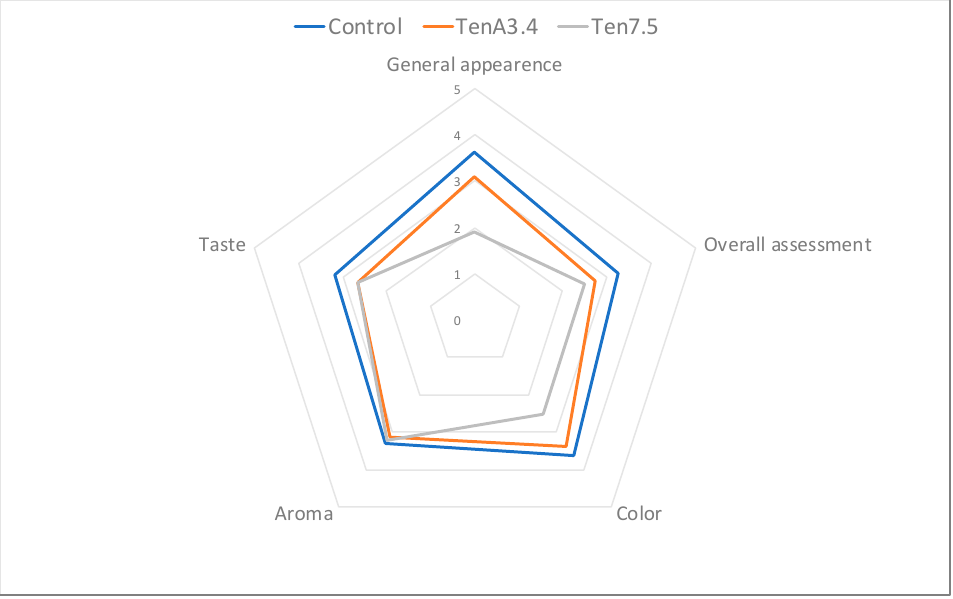
Figure 7. Average responses of the panelists ( n = 47) for the control and the sauces with 1.7% and 7.5% Tenebrio molitor flour for different sensory attributes and the overall appreciation.